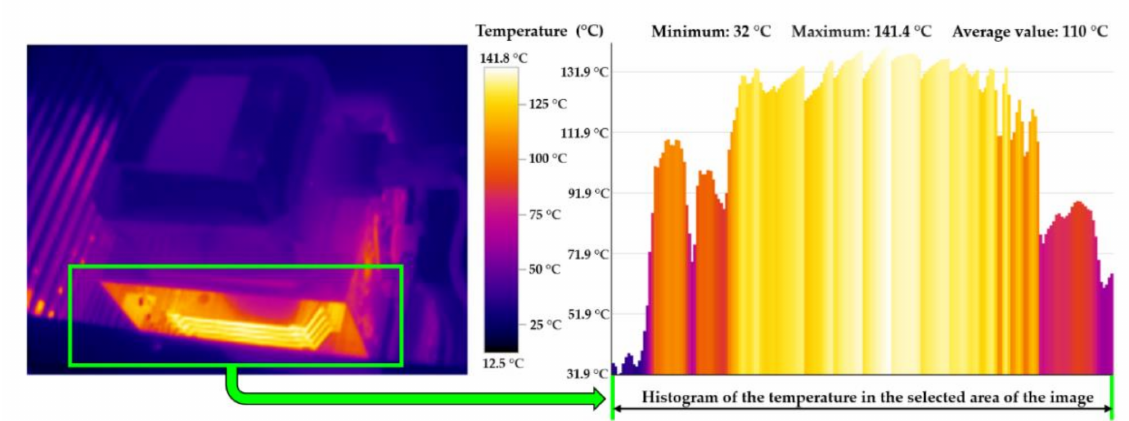
Figure 4. Display of a heated magnetron without optimized cooling after 90 s of full